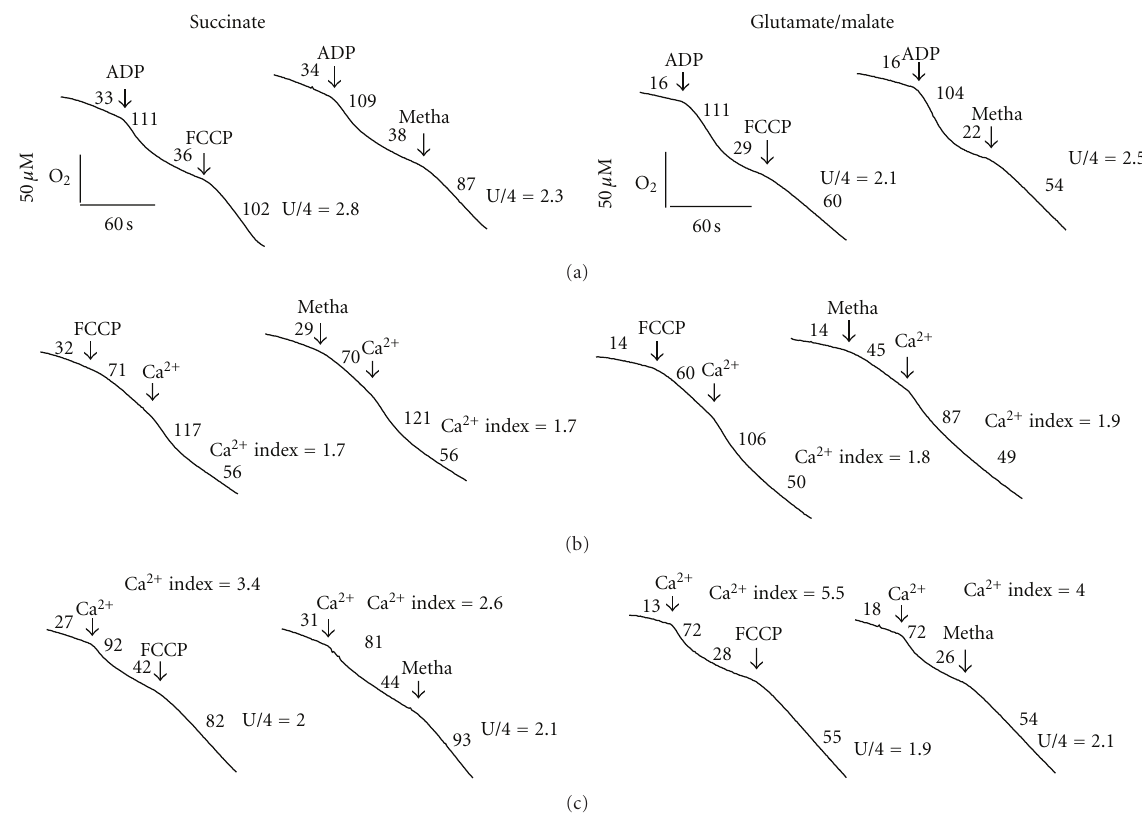
Figure 3: Methadone a ff ects mitochondrial Ca 2+ uptake in a respiratory substrate-dependent way. Oxygen uptake by isolated liver mitochondria was determined using a Clark electrode in the presence of 5 mM succinate or 2.5 mM glutamate/2.5 mM malate as substrates. (a) Uncoupling capacity of FCCP and methadone. (b) The e ff ect of FCCP and methadone on Ca 2+ uptake. (c) The e ff ect of Ca 2+ uptake on the uncoupling capacity of FCCP and methadone. Additions: 250 μ M ADP, 200 μ M CaCl 2 , 0.4 μ M FCCP, and 0.5 mM methadone. Traces shown are the means obtained from four independent mitochondria preparations. Numbers on the traces indicate respiration rates at 37 ◦ C in nmol oxygen · mg protein − 1 · min − 1